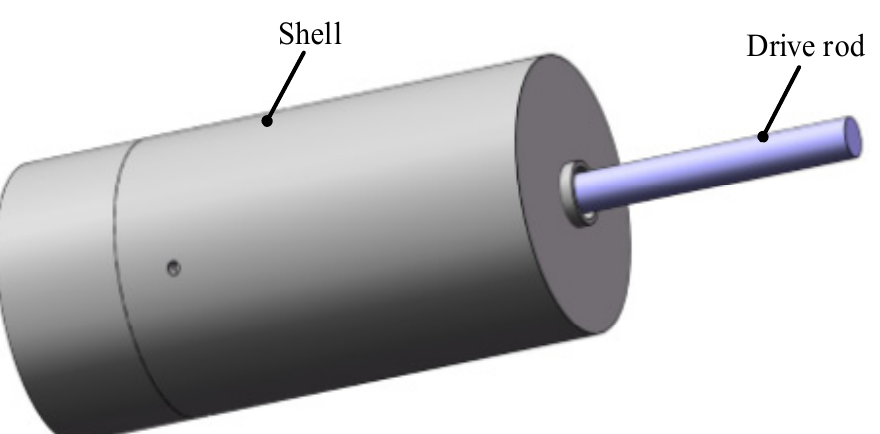
Figure 1. The external structure of the actuator.